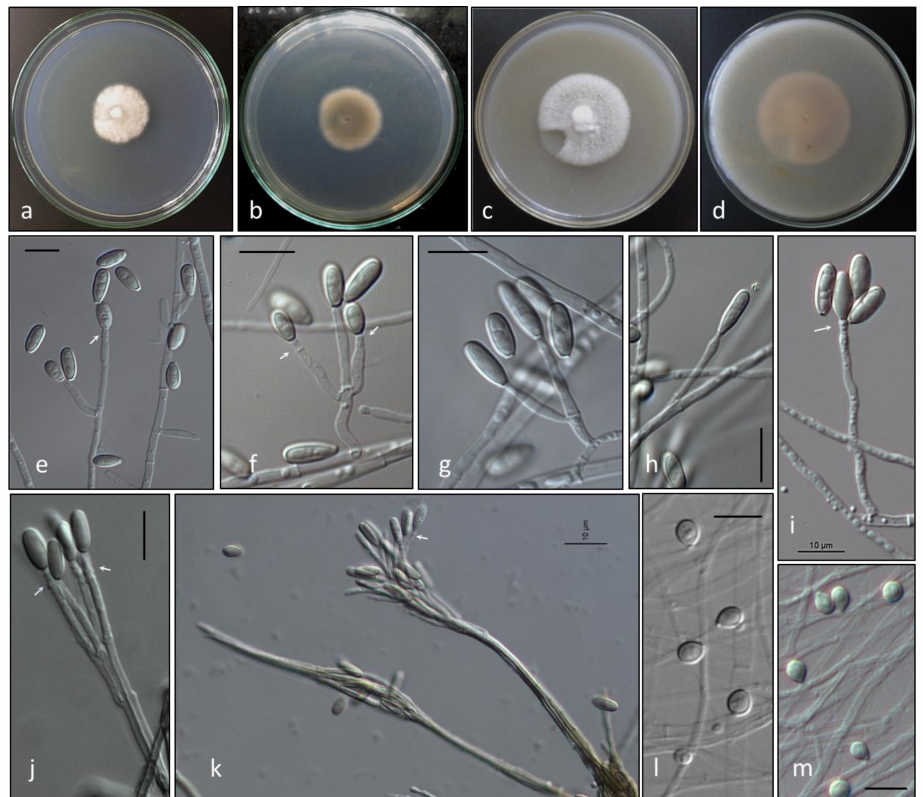
Figure 4. Scedosporium americanum DMic 165285 T . Colony on PDA ( a , surface; b , reverse), and on OA ( c , surface; d, reverse) after 14 days at 25 ◦ C. Conidiogenous cells and conidia ( e – i ). Synnematous conidiomata. ( j , k ). Sessile conidia ( l , m ). Arrows indicate annellations at the top of conidiogenous cells. Bars = 10 µ